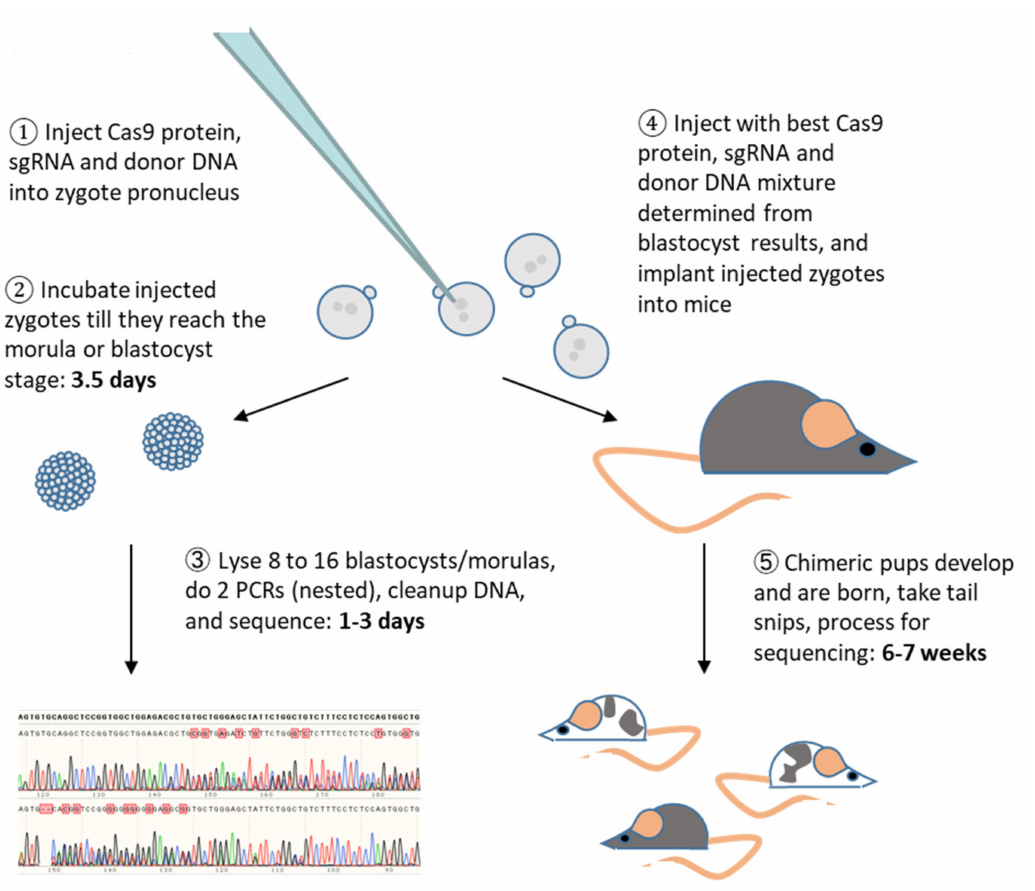
Figure 2. Workflow. Zygotes injected with CRISPR components are developed first to the blastocyst stage and used to determine the e ffi ciency of the components. If results from the blastocysts are good, new zygotes are injected with the same CRISPR mixture and used to make